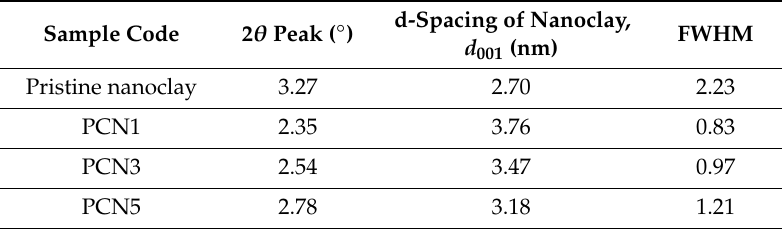
Table 2. Nanoclay interlayer characteristics by XRD